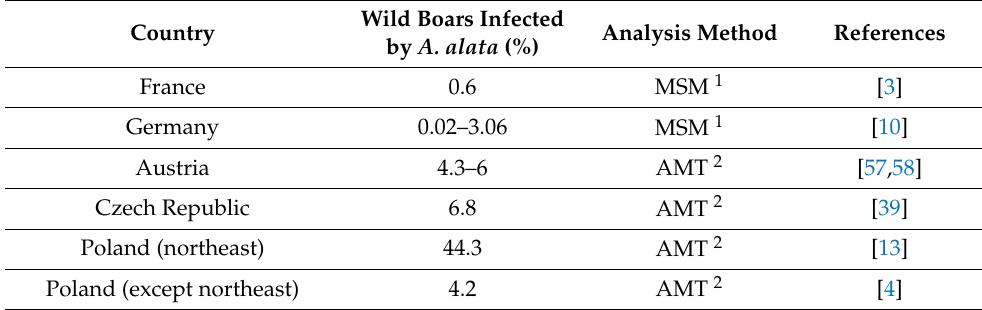
Table 2. Prevalence of A. alata in wild boars in